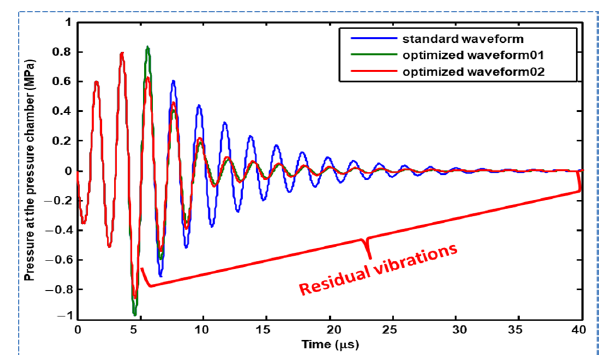
Figure 12. Comparison of Waveform 01 and Waveform 02 and their effect on residual vibrations.